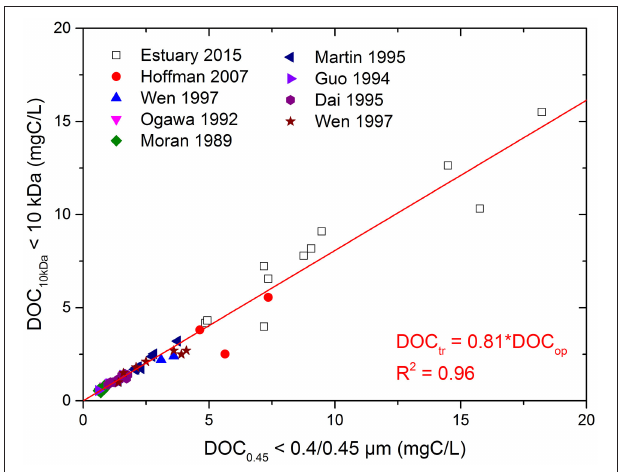
FIGURE 4 | Relationships between DOC 10kDa and DOC 0.45 for < 10 kDa DOC and 0.4/0.45 µ m DOC of samples from this study and literature.